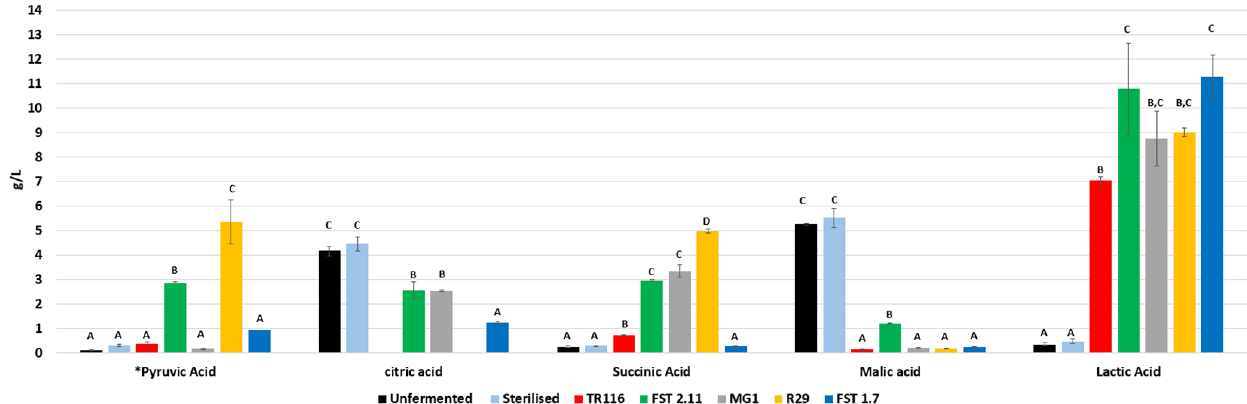
Figure 2. GC-MS metabolomic analysis of rootlet ingredients. TR116, FST2.11, MG1, R29 and FST 1.7 represent barley rootlets fermented with Leuconostoc citreum TR116, Lactobacillus amylovorus FST2.11, Weissella cibaria MG1, Limosilactobacillus reuteri R29 and Lactiplantibacillus plantarum FST1.7, respectively. Error bars on the graph indicate the standard deviations found within samples. * indicates relative peak area values, which are normalised based on an internal standard (deuterium- labelled alanine). No statistical difference was found with values in the same row which share the same uppercase letter.